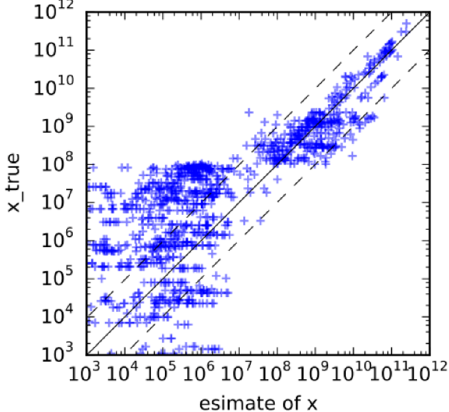
Fig. 2. Comparison of “ true ” and “ estimated ” ETEX